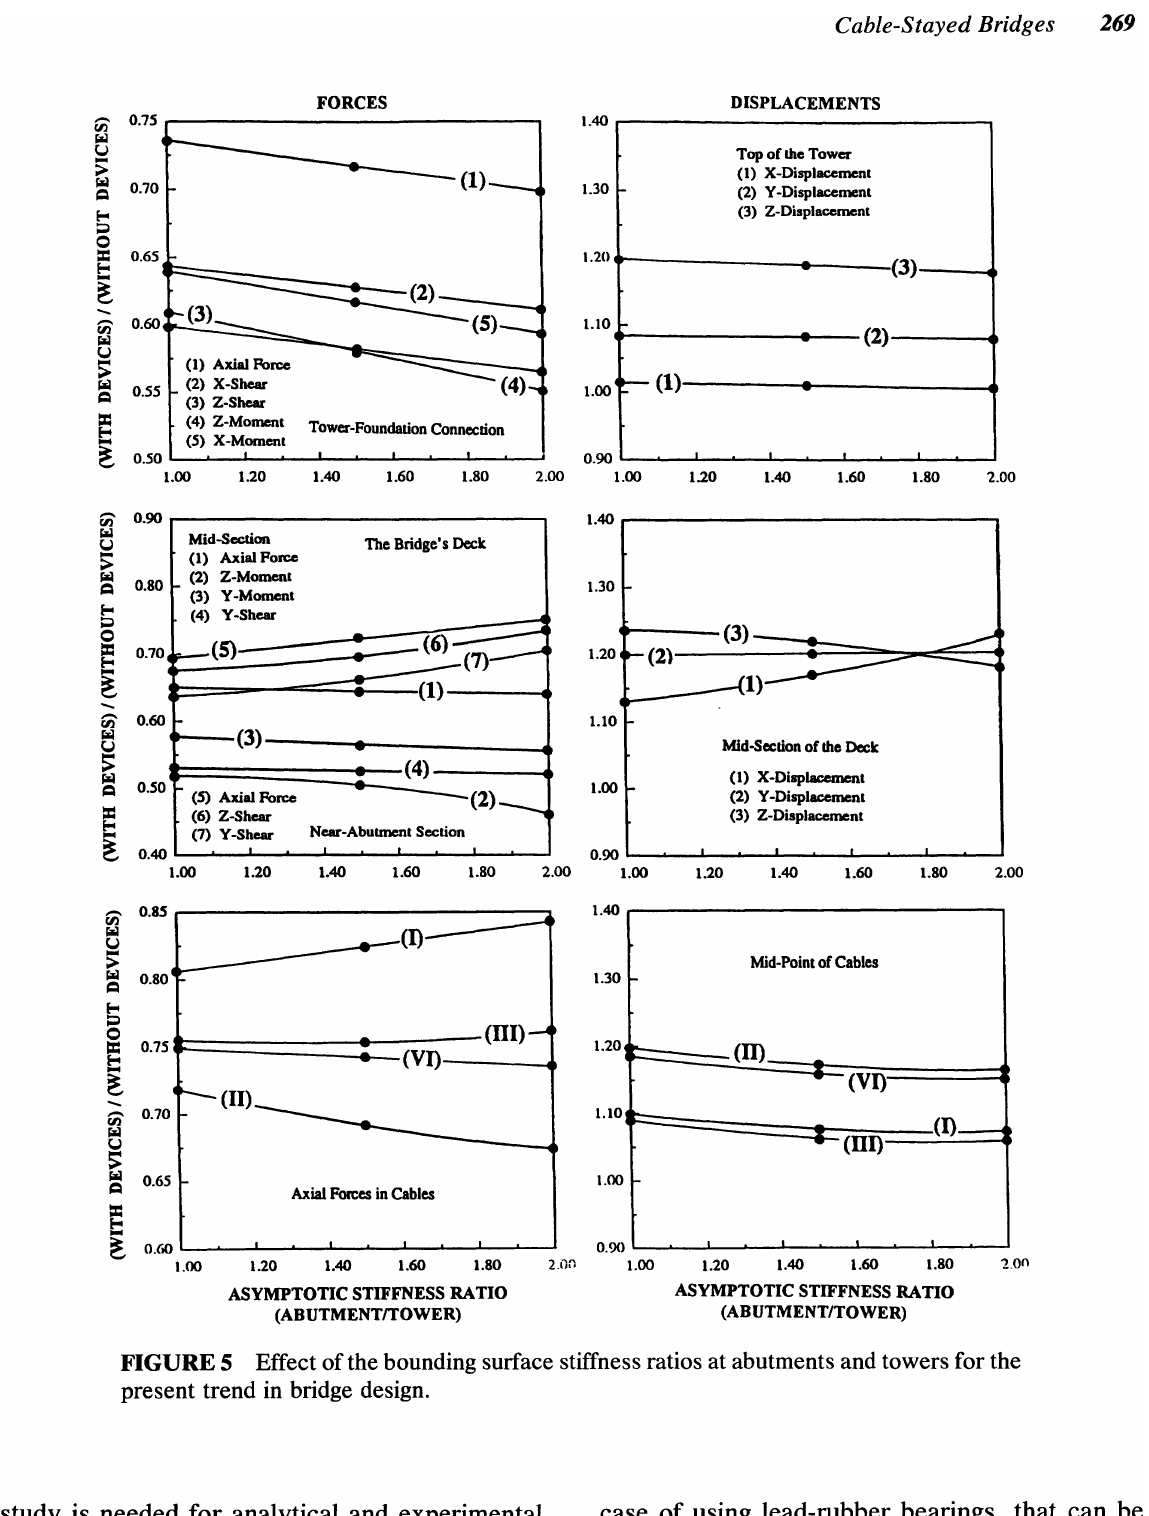
FIGURE 5 Effect of the bounding surface stiffness ratios at abutments and towers for the present trend in bridge